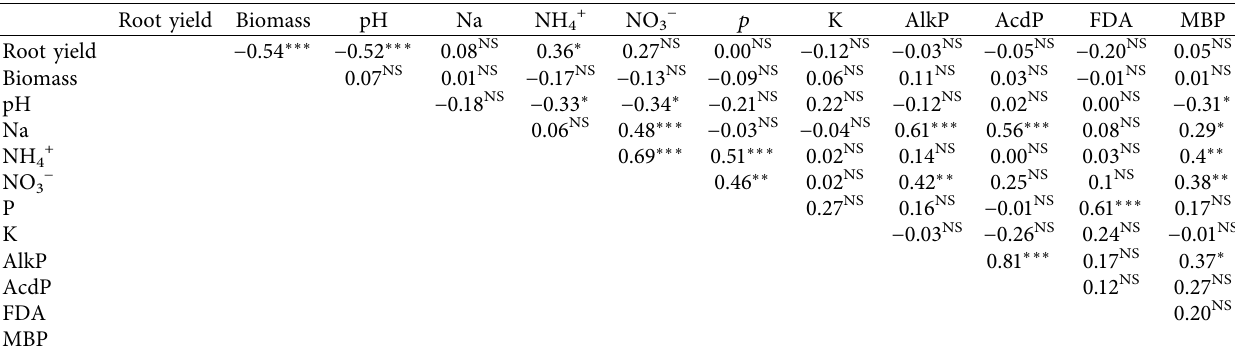
Table 2: Correlation matrix between sweet potato performance and soil